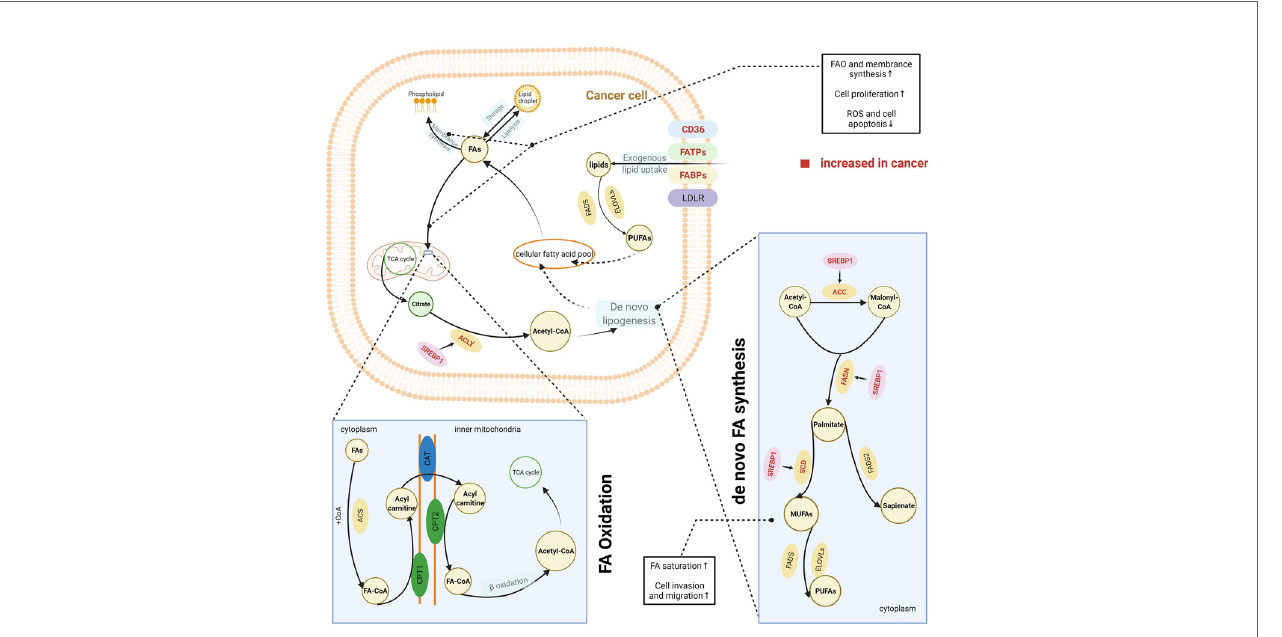
FIGURE 2 | Lipid metabolism reprogramming in cancer cells. To satisfy the requirements for cancer cell survival and proliferation, cancer cells have an increased uptake of exogenous lipids and a high level of de novo synthesis. Exogenous uptake of lipids is increased in cancer cells through upregulating multiple transporters, including CD36, FATPs, and FABPs. De novo FA synthesis is activated in cancer cells. This is achieved through the overexpression of lipogenic enzymes, induced by the activation of SREBPs. Abundant lipids can support the malignant proliferation of cancer cells by providing necessary substrates for membrane synthesis and metabolic fuels via b -oxidation. Increased FAO can also help reduce cell apoptosis by eliminating reactive oxygen species. In addition, balance between saturated and unsaturated FAS was achieved by lipid reprogramming to enhance the capacity of invasion and migration in cancer cells. The excess lipids are stored into LDs. The fi gure was created with BioRender.com. ACC, acetyl-CoA carboxylase; ACLY, ATP citrate lyase; ACS, acyl-CoA synthetase; CAT, carnitine translocase; CD36, cluster of differentiation 36; CPT, carnitine palmitoyltransferase; ELOVL, fatty acid elongase; FA, fatty acid; FABPs, fatty acid-binding proteins; FA-CoA, fatty acyl- CoA; FADS, fatty acid desaturase ( D 5 or D 6); FAO, fatty acid oxidation; FASN, fatty acid synthase; FATPs, transport proteins; LD, lipid droplet; LDLR, low-density lipoprotein receptor; MUFA, monounsaturated fatty acid; PUFA, polyunsaturated fatty acid; SCD, stearoyl-CoA desaturase ( D 9); SREPs, sterol regulatory element binding proteins; TCA cycle, tricarboxylic acid